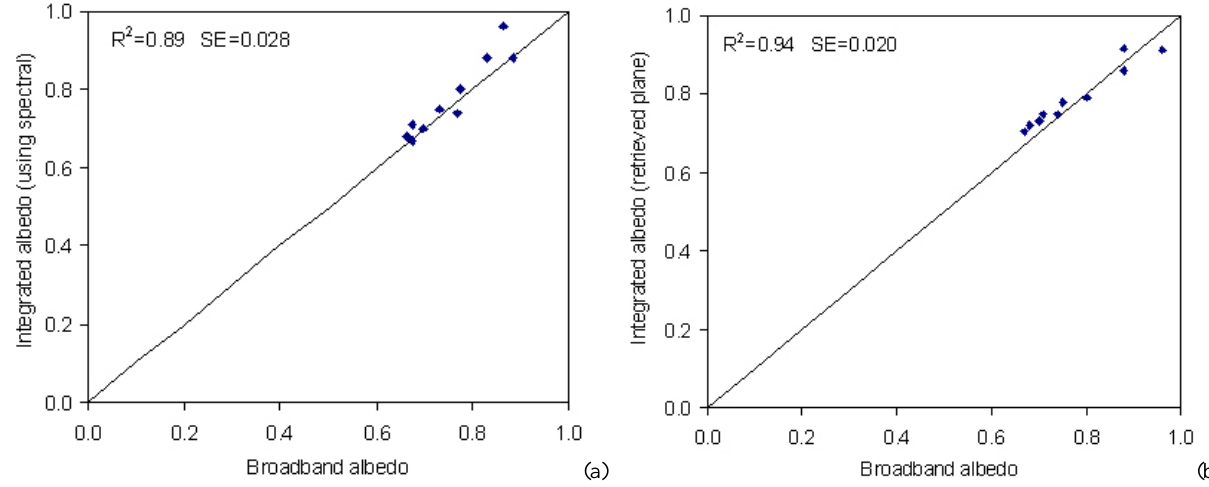
Fig. 8. The comparison between (a) broadband albedo and integrated albedo measured using spectroradiometer; (b) broadband albedo and simulated integrated albedo from reflectance measurement using the ART theory.